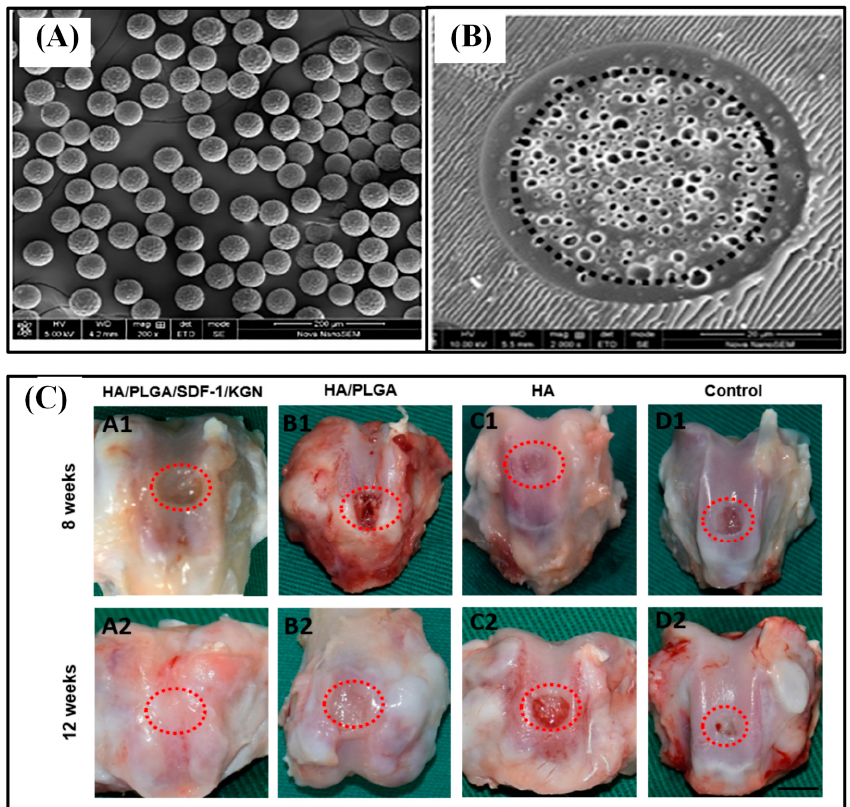
Figure 8. SEM image of PLGA core–shell microspheres ( A ) and its cross-sectional morphology ( B ). Gross evaluation of the repaired tissue at 8 and 12 w ( C ). The scale bar is 3.5 mm. Reproduced with permission from